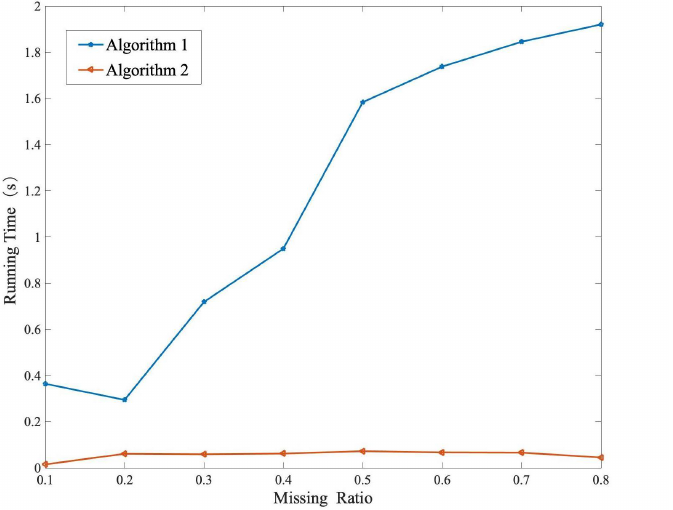
Figure 4. The running time comparison of Algorithms 1 and 2 under different missing